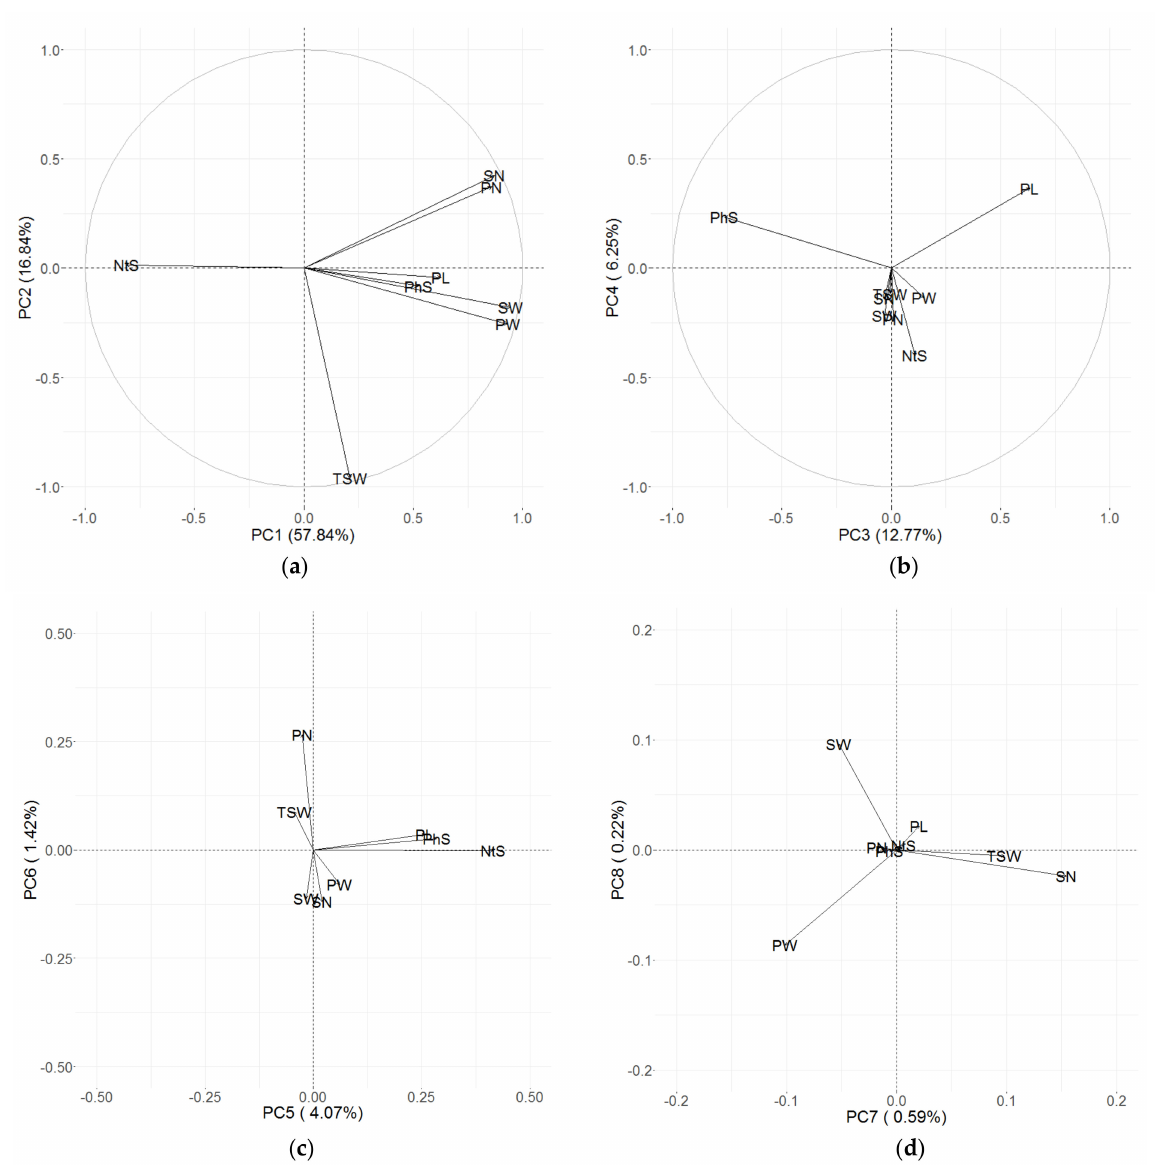
Figure 5. Variable factor maps demonstrating the relations between traits in PC coordinates ( a ) PC1 and PC2, ( b ) PC3 and PC4, ( c ) PC5 and PC6, ( d ) PC7 and